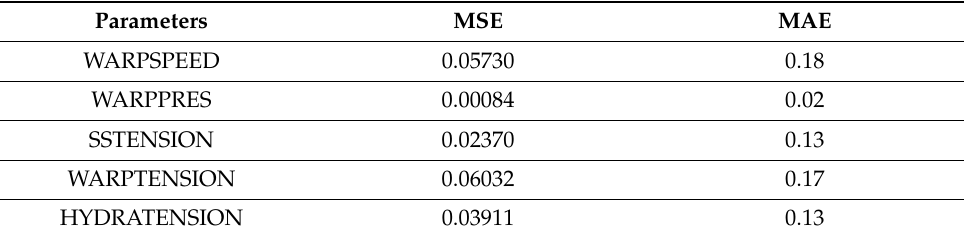
Table 10. Elastic net results for the warping process.